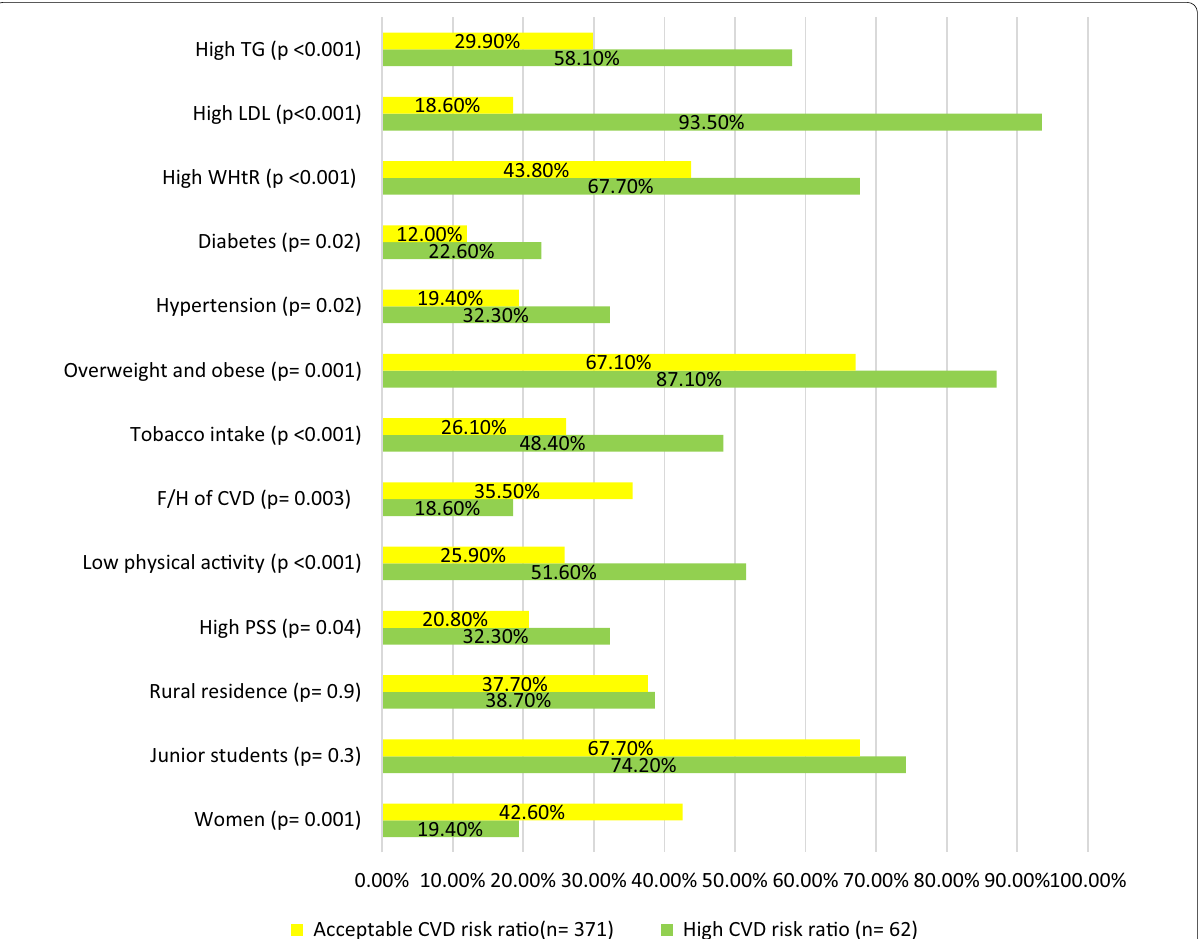
Fig. 3 Association of the baseline parameters and CVD risk factors with CVD risk